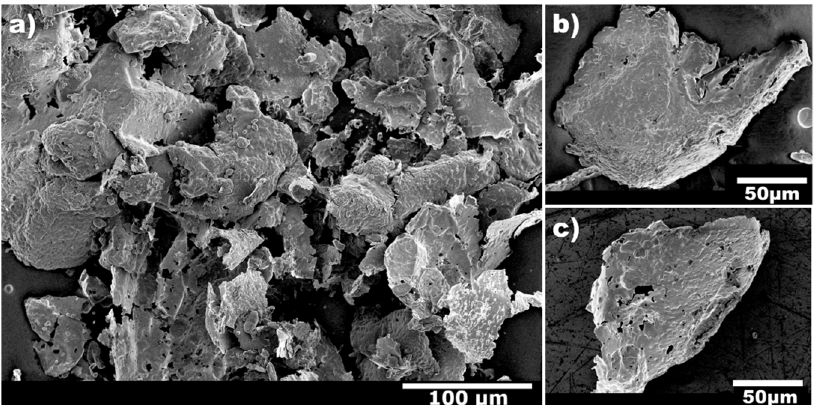
Figure 5. SEM images of the washed-off C-TiO 2 +Ni particles: ( a ) general overview of particles; ( b ) the photocatalyst side of C-TiO 2 +Ni particle; and ( c ) Ni side of C-TiO 2 +Ni particle.